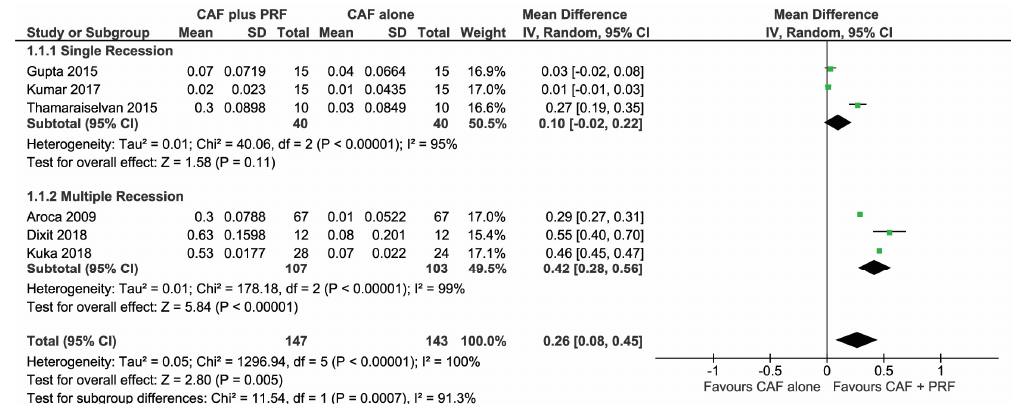
Figure 3. Comparison of change in width of keratinized gingiva (WKG) between CAF + L-PRF versus CAF alone with 6–12 months follow-up. 3.1.3. Change in Root Coverage Percentage (%RC) A total of 6 studies [30,31,33–35,37], which were analyzed in the forest plot to find the change in %RC among the CAF + L-PRF group and the CAF alone group, showed no significant mean difference (MD 8.23 95% CI ( − 4.00,20.47), p = 0.19) post 6–12 months follow-up, seen in Figure 4.